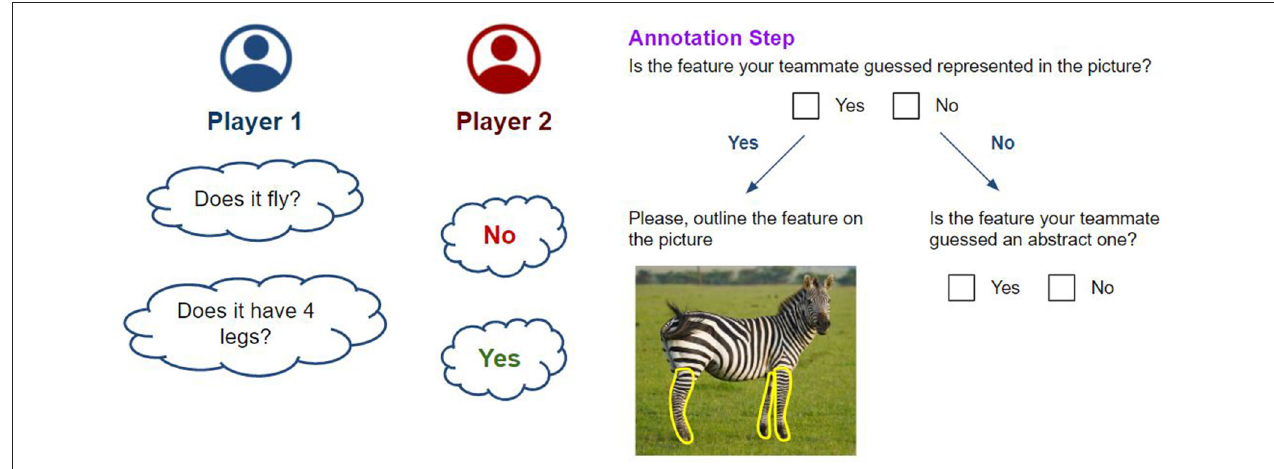
FIGURE 3 | On the left, the Basic Turn of the gamified activity is displayed. Player 1 asks yes or no questions about the entity. Player 2 answers such questions. On the right, the Annotation Step is summarized. Player 2 is asked to complete a series of simple tasks to identify the guessed feature by answering questions and potentially annotating the